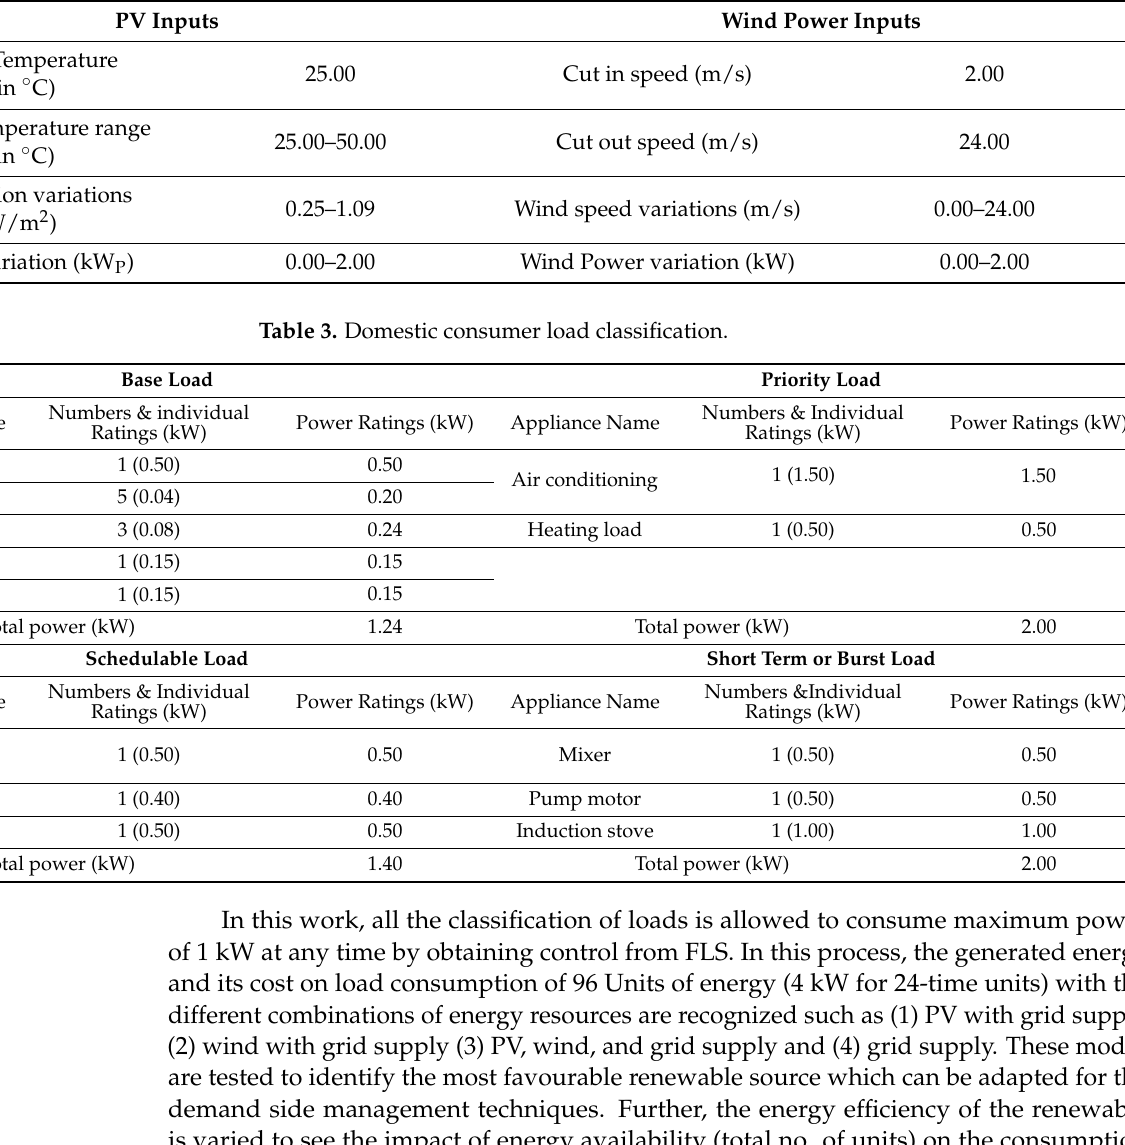
Table 2. List of main inputs for the simulation process.